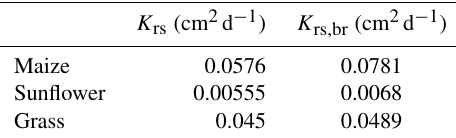
Table 4. Root system conductances, K rs , and root system conduc- tances of the big root model, K rs,br , estimated from root segment